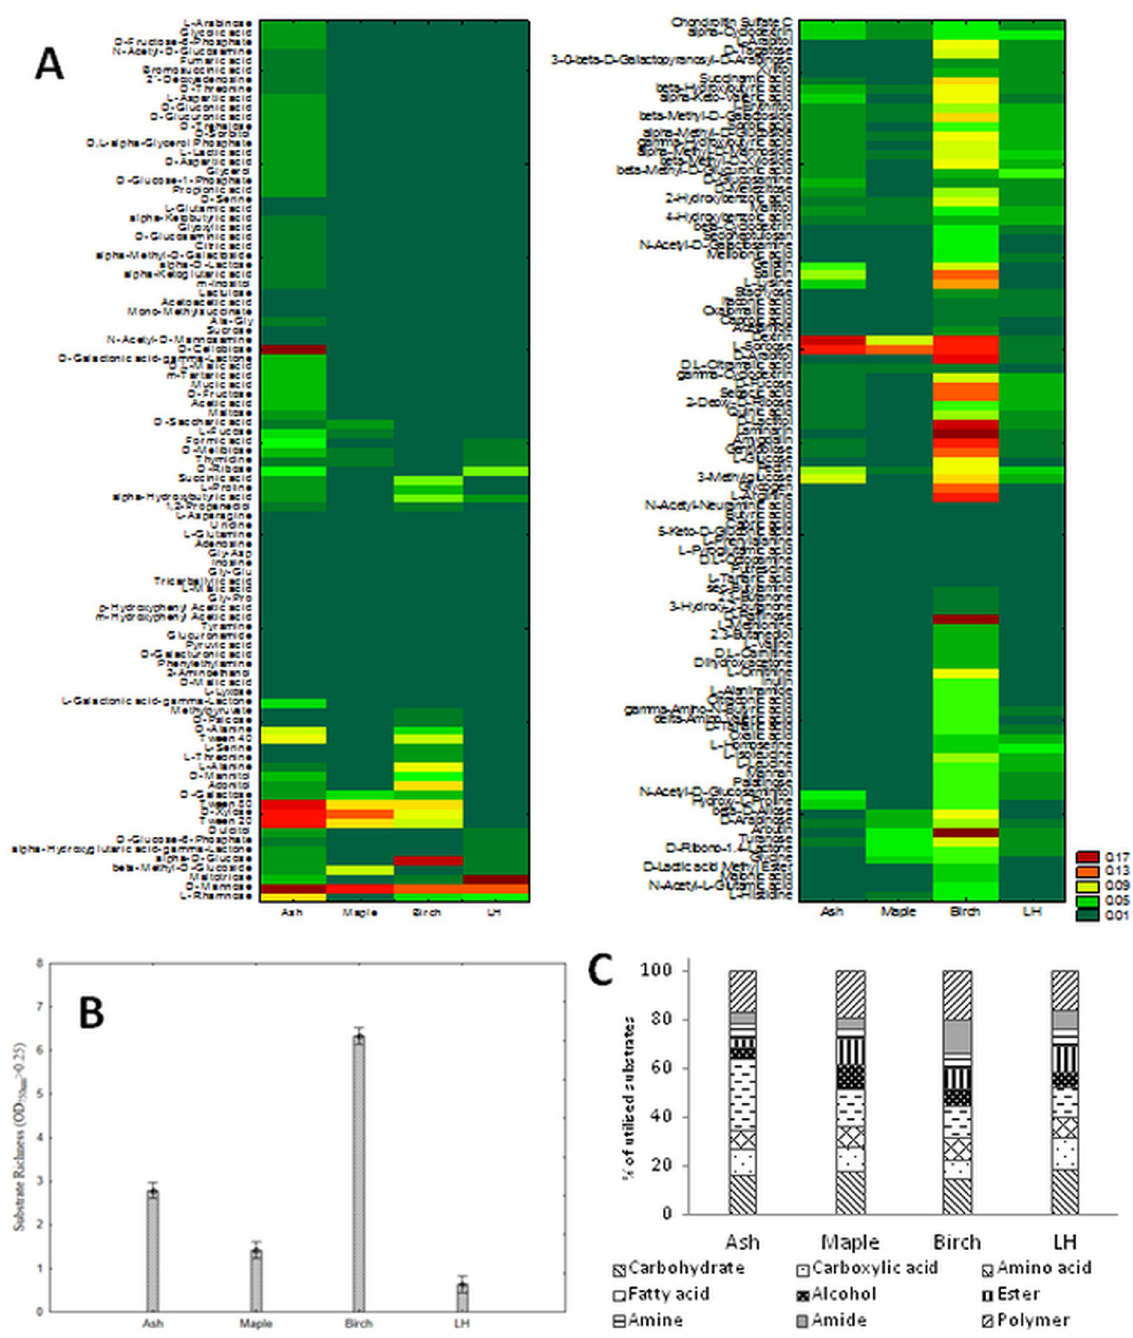
Fig 3. Utilization profiles of C . unicolor grown on different sawdust substrates. (A) Phenotype profiles of C . unicolor FCL139 obtained with PM1 and PM2 panels after fungus precultivation on ash, maple, and birch sawdust and LH control medium. The color scale applied into the heat maps indicates the growth of the fungus (OD 750 nm) on a particular substrate. (B) Substrate richness values of C . unicolor FCL139 precultured on ash, maple, and birch sawdust and LH mineral medium; vertical bars denote 0.95 confidence intervals. (C) Metabolic preferences of C . unicolor FCL139 towards particular carbon and energy sources observed after fungus precultivation in media containing different sawdust substrates and LH control medium.